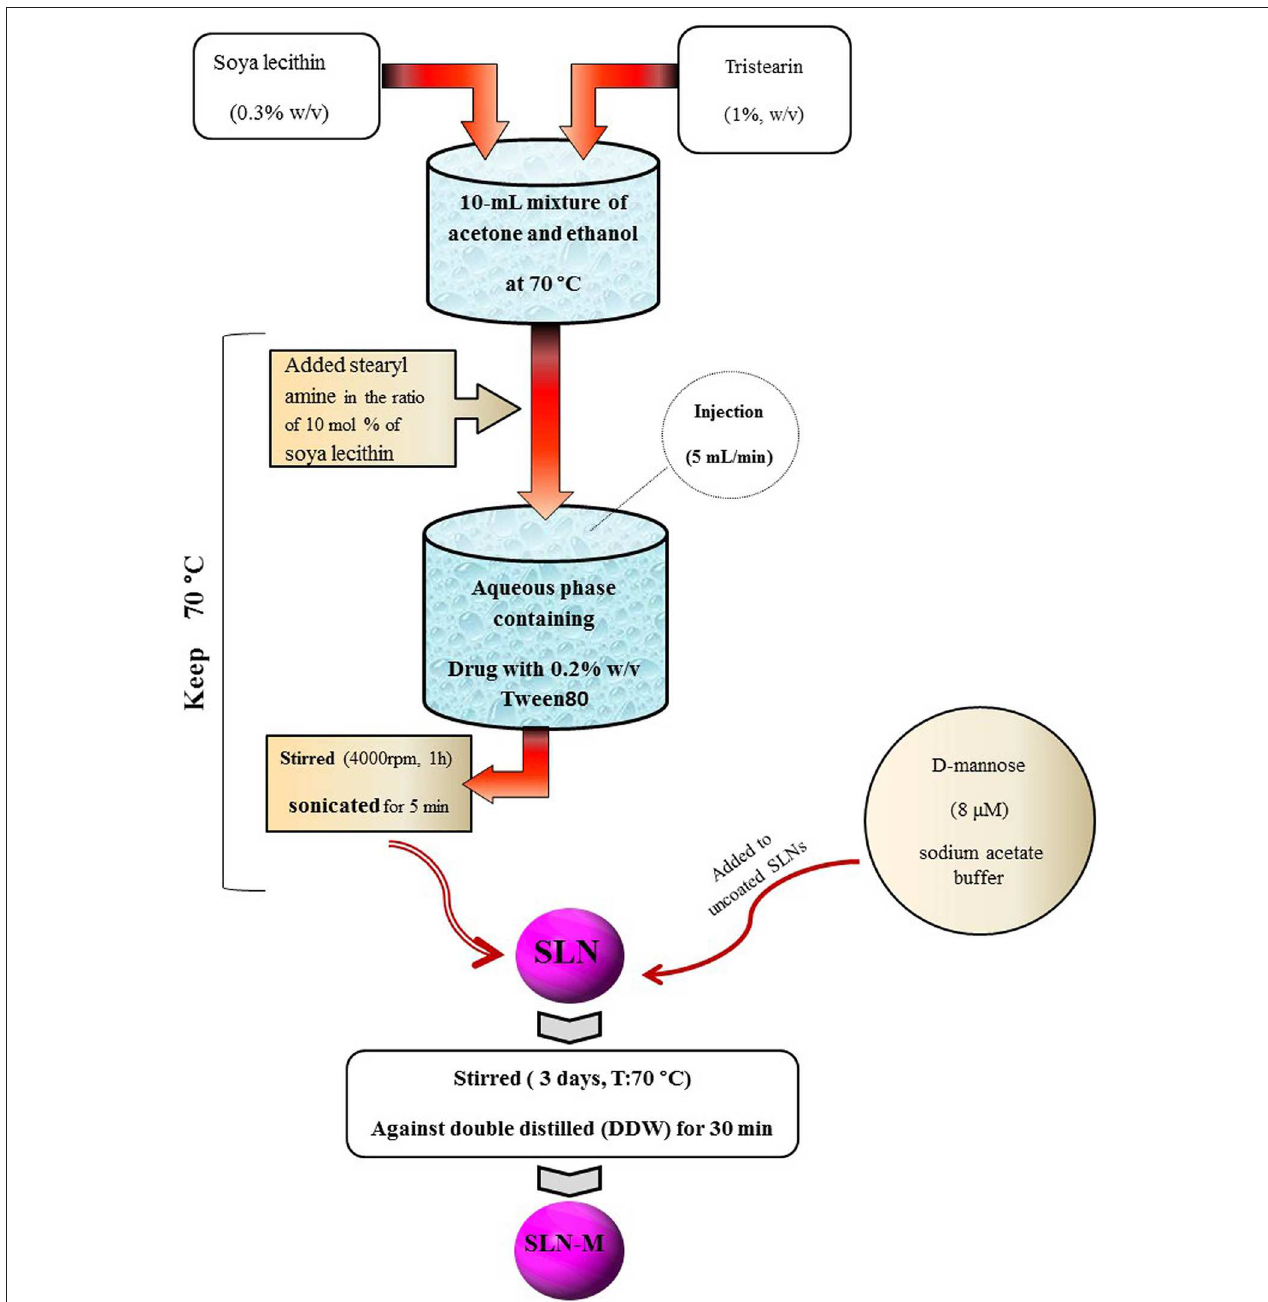
FIGURE 1 | Schematic protocol describing the processing of PM-SLN-M